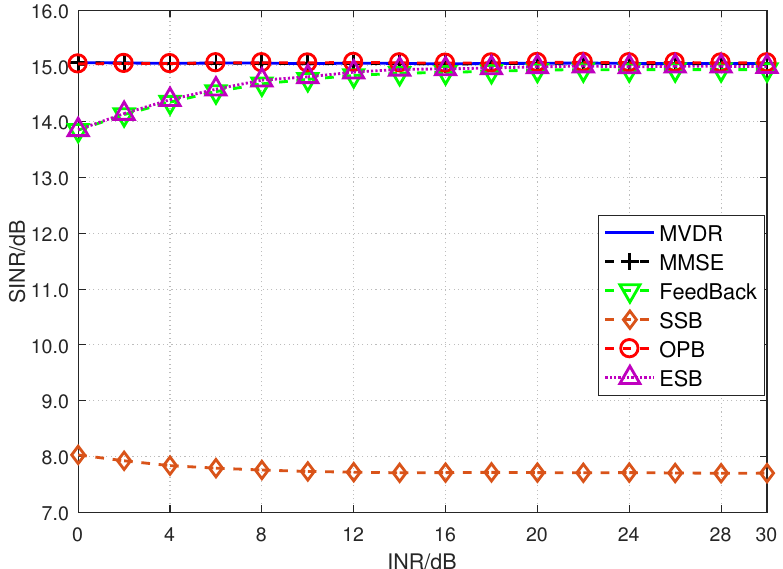
Figure 5. Output SINR versus the input